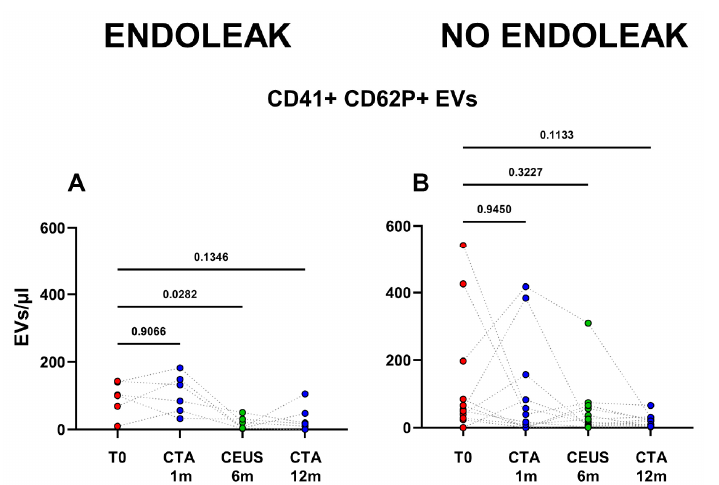
Figure 5. Patients were analyzed at baseline (T0), and after 1, 6, and 12 months following EVAR intervention, as established in the clinical protocol. In ( A , B ) dots represent numbers of peripheral-blood EVs stemming from activated platelets (CD41+ CD62P+) in the two cohorts of patients (Endoleak and No Endoleak). Each line connects the time points of a single donor. Repeated measures one-way ANOVA or a mixed-effects model was used to compare the means of the different time points. Dunnett’s multiple comparison test was used for multiple comparisons.